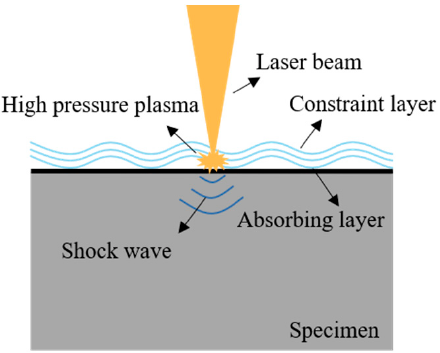
Figure 1. Schematic diagram of LSP.